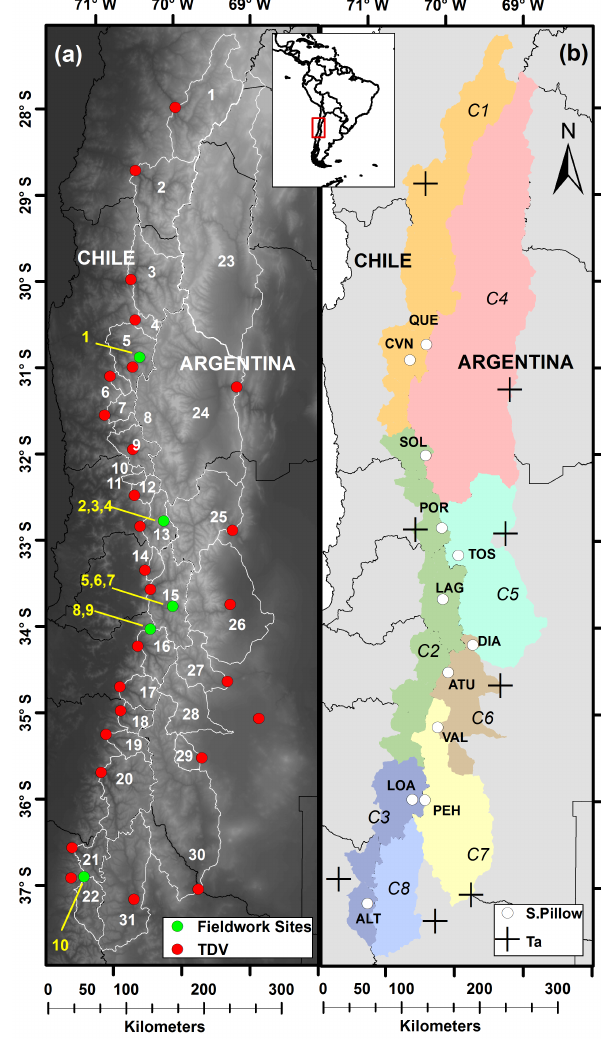
Figure 1. Study area and model domain: (a) river basins, stream gages (red circles) and sites where snow survey data are available (green circles); (b) hydrologic units (C1 to C8) and snow-pillow stations (white circles).